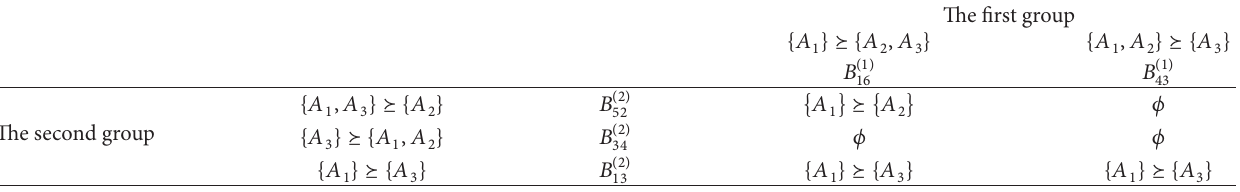
Table 4: The preference intersections for Dempster-Shafer combination rule.